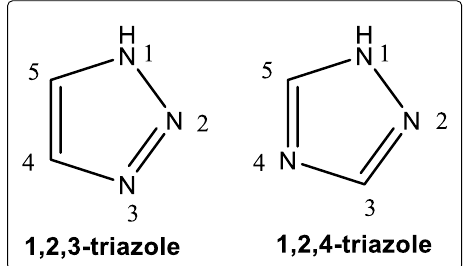
Figure 2. Isomers of triazole.